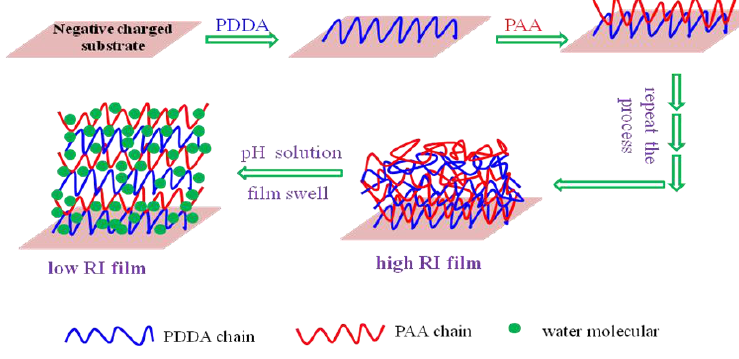
Figure 5. Schematic principle of TFBG based pH sensor.